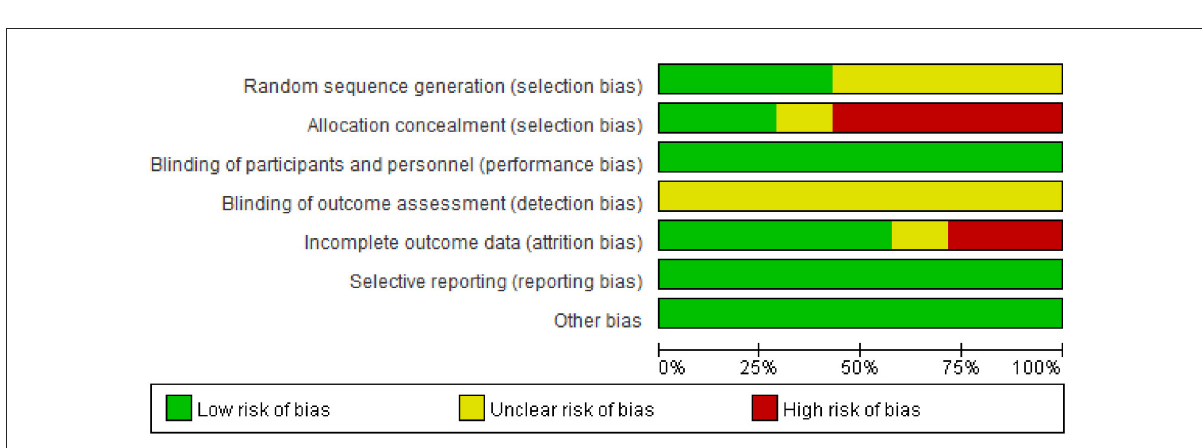
group < 0.1). The lighting parameters were extracted from the 7 clinical trials and analyzed. The results for a total of 258 participants were evaluated, of which 130 patients received H- CS lighting therapy (CS > 0.1) and 128 patients received a